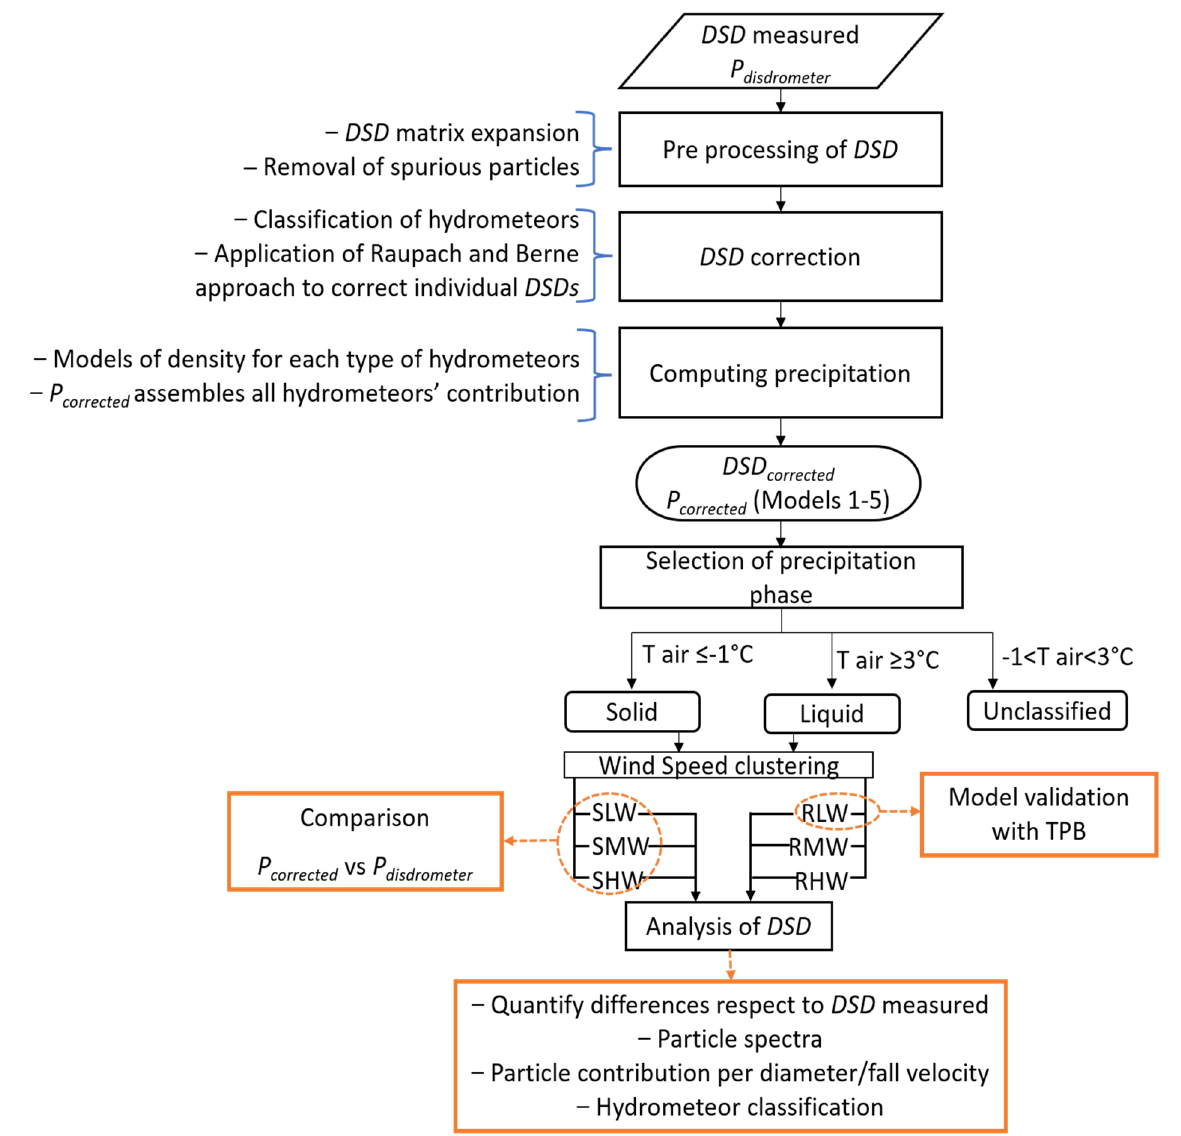
Figure 3. Scheme of processes applied to obtain diameter size distributions ( DSD ) and precipitation corrected. Then, the records were classified as solid, liquid, and unclassified precipitation using air temperature. Finally, the solid (S) and liquid (R) sets were introduced to be clustered in low (LW), medium (MW), and high (HW) wind speed.